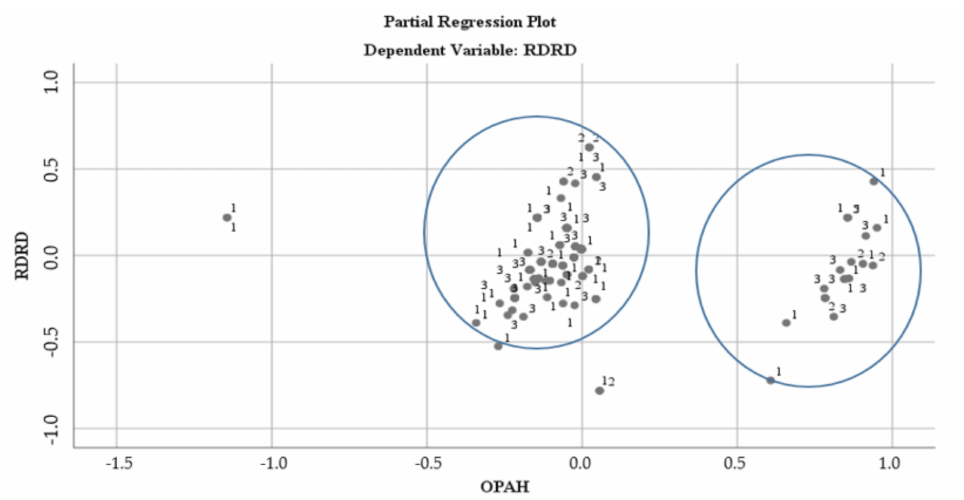
Figure 9. Regression analysis for